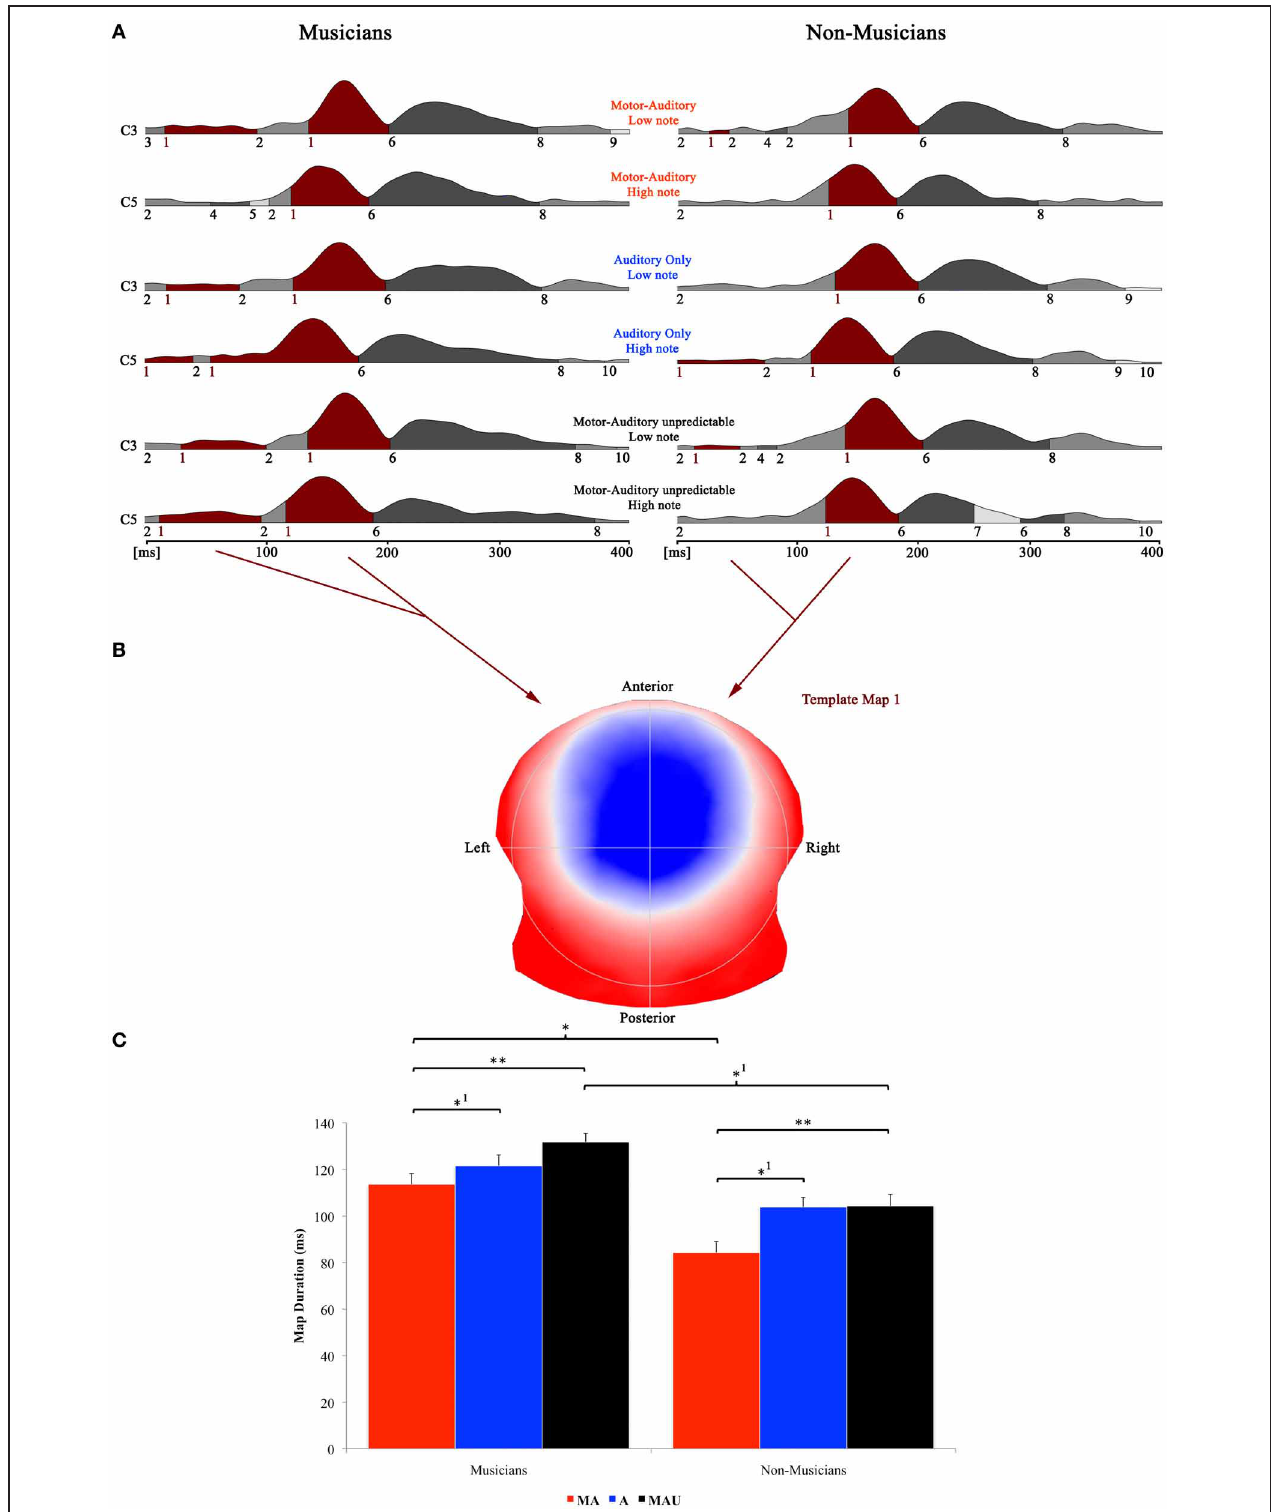
FIGURE 4 | Evoked potential data; piano condition. (A) Segments of stable map topography are shown group wise (left: musicians, right: non-musicians) for each condition under the global field power curve from 0 to 400ms. The numbers below the segmentation landscape indicate the